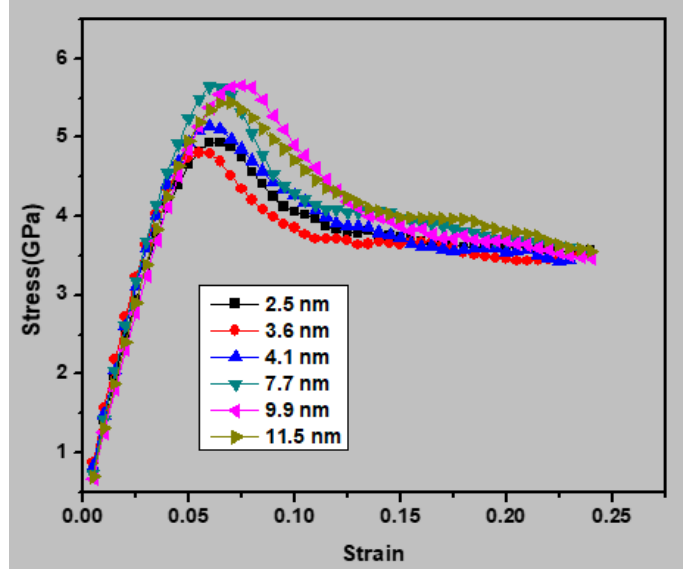
Table 1. Mechanical properties of the nanocrystalline austenitic stainless steel samples at room temperature.